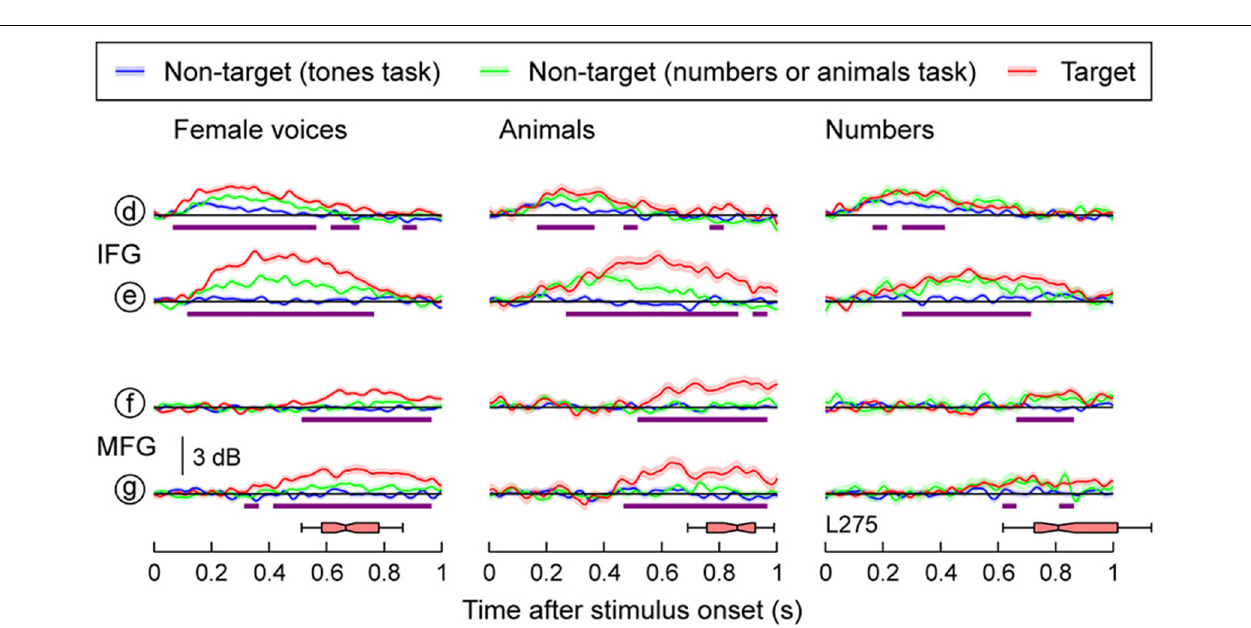
FIGURE 5 | Task effects on responses to speech stimuli in IFG and MFG. High gamma responses to three types of stimuli (female voices, animals, numbers; columns), presented in three different tasks (blue, green and red plots), are shown for two recording sites on the IFG and two sites on MFG. See Figure 3A for location of the sites. Lines and shaded areas represent